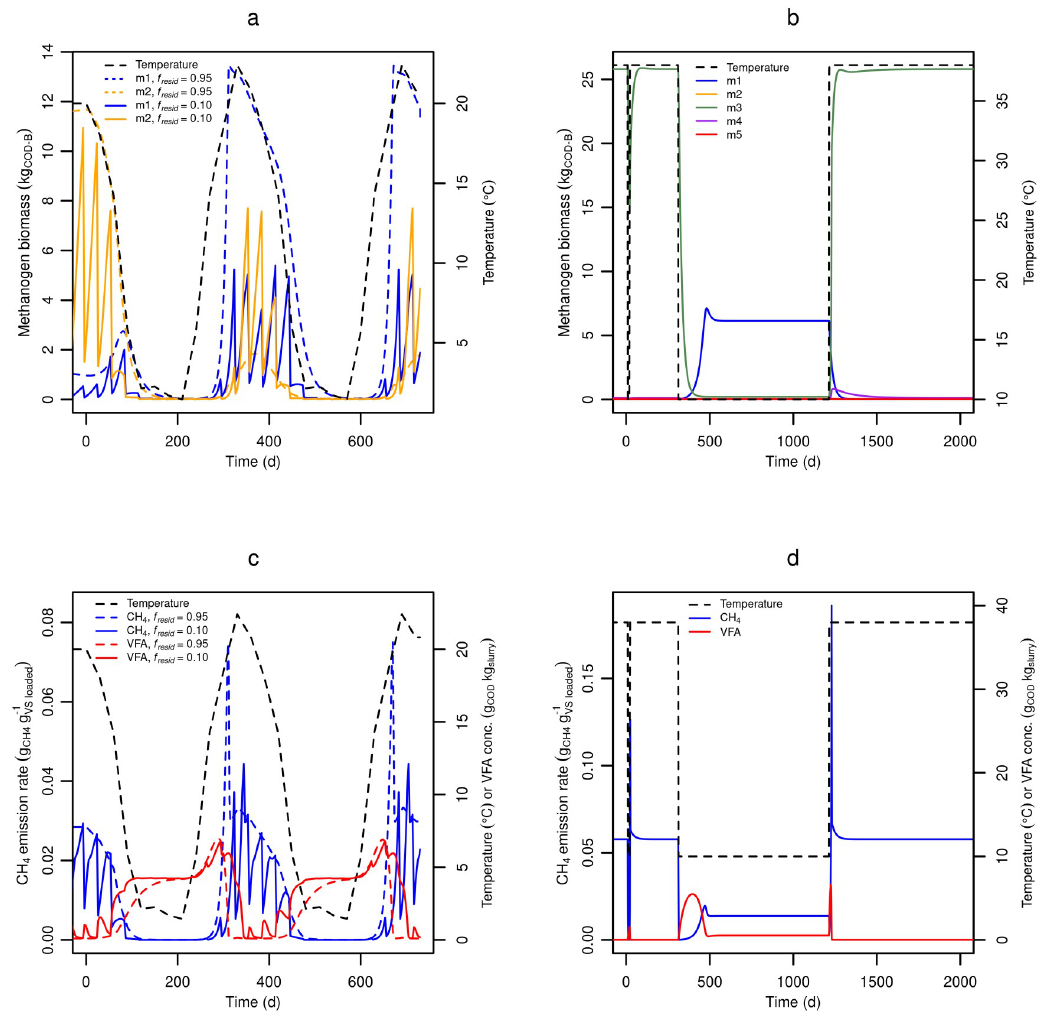
Fig 6. Predicted temperature effects on methanogens and methane production. (a) Methanogen biomass and (c) CH 4 emission during gradual slurry temperature changes as predicted with a high and low residual slurry fraction in the storage (f resid ). (b) Methanogen biomass and (d) CH 4 emission during short- and long-term temperature changes using a large residual fraction of slurry ( f ) of resid